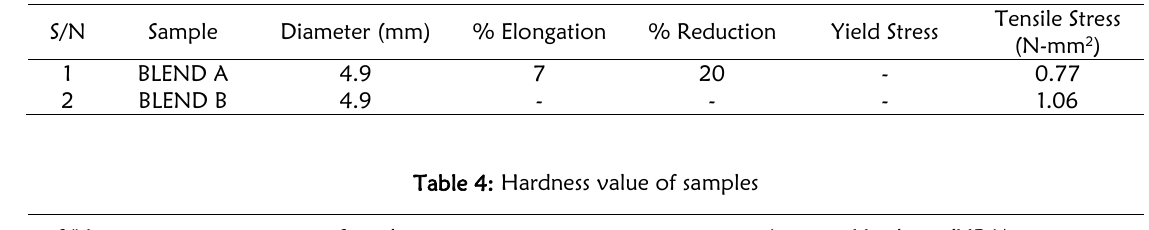
Table 3: Percentage Elongation/Reduction, Yield/Tensile stress of the samples